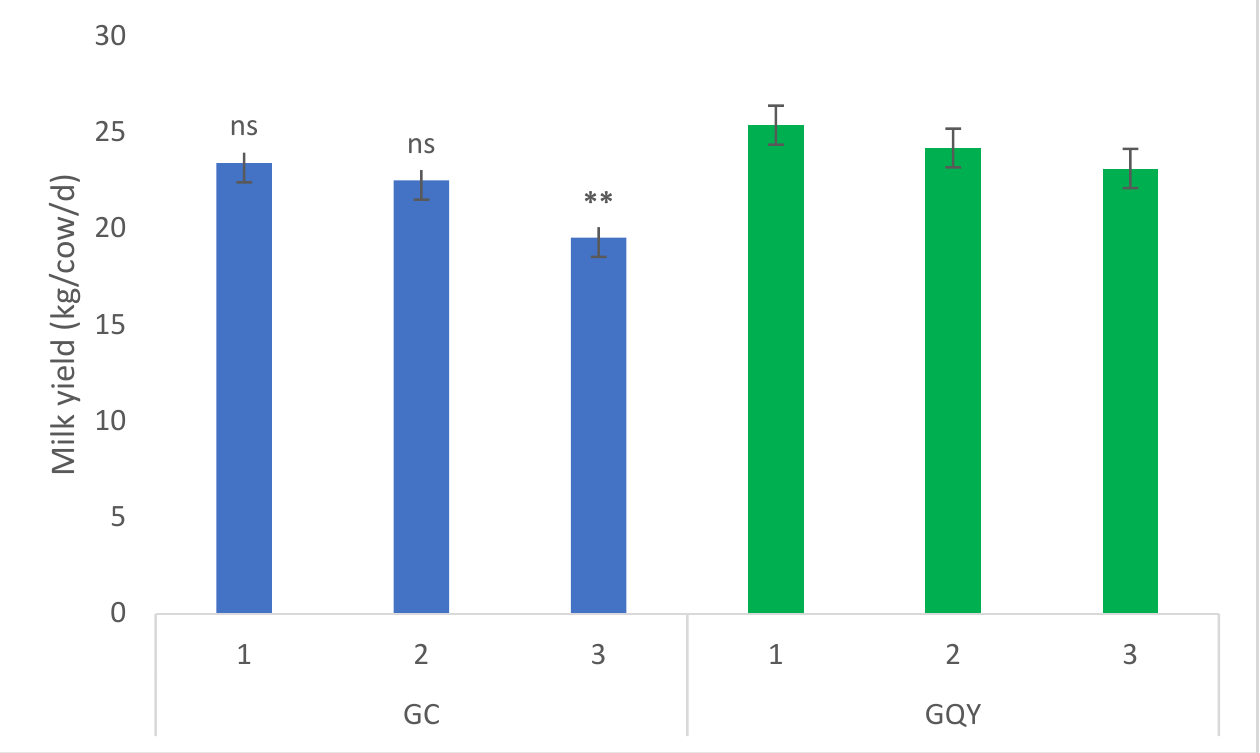
Figure 2. Evolution of milk yield over the 3 samplings in the group receiving the QY (GQY) and the group control (GC). Abbreviations: ns, not significant; **: p < 0.01.